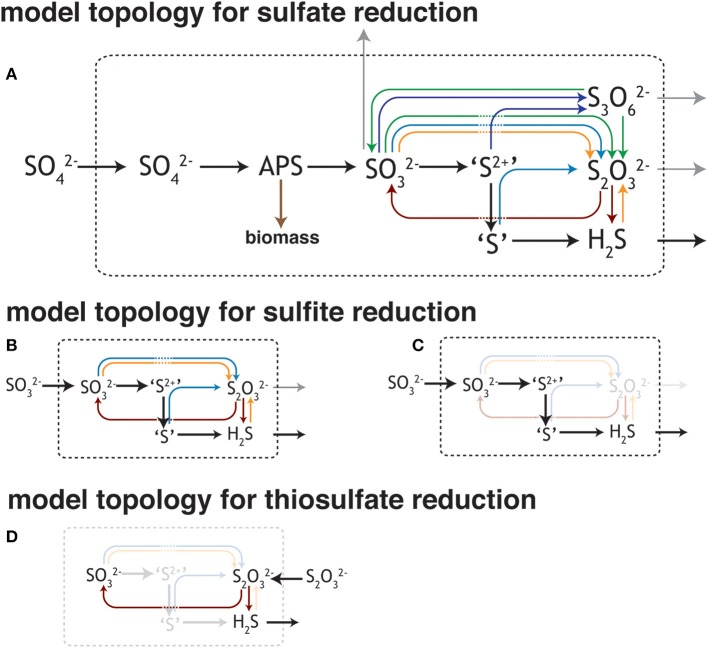
Different views of the sulfate reduction metabolic network. (A) The model of dissimilatory sulfate reduction modified from Bradley et al. (2011). As it relates to this study, the schematic outlines the potential for numerous reactions between sulfite/bisulfite (HSO−3/SO2−3) and hydrogen sulfides/bisulfide (H2S/HS−) (insets B–D). As the isotopic consequences of most of these potential reactions are unknown or under-constrained, this work aims to better assay both the isotope effects and conditions that favor the production of some of these intermediates. Outlined here are the potential reactions for (B,C) sulfite and (D) thiosulfate [(S-SO3)2−] reduction, given the standard model of the biochemistry associated with sulfate (SO2−4) reduction (A). Trithionate [(3OS-S-SO3)2−] is included here, however not observed in this study. This is not an exhaustive depiction of the MSR network, though is a testable topological prediction that would be better informed with future biochemical inquiry (c.f. Venceslau et al., 2014). The valence of the S as it moves through the pathway: sulfate and APS (6+), sulfite (4+), outer S's in trithionate (4+), central S in trithionate (2+), sulfonate S in thiosulfate (5+), reduced S in thiosulfate (0 to 1−), sulfide/hydrogen sulfide (2−). The values for trithionate are best estimates, while those for thiosulfate are from the literature (Vairavamurthy et al., 1993).